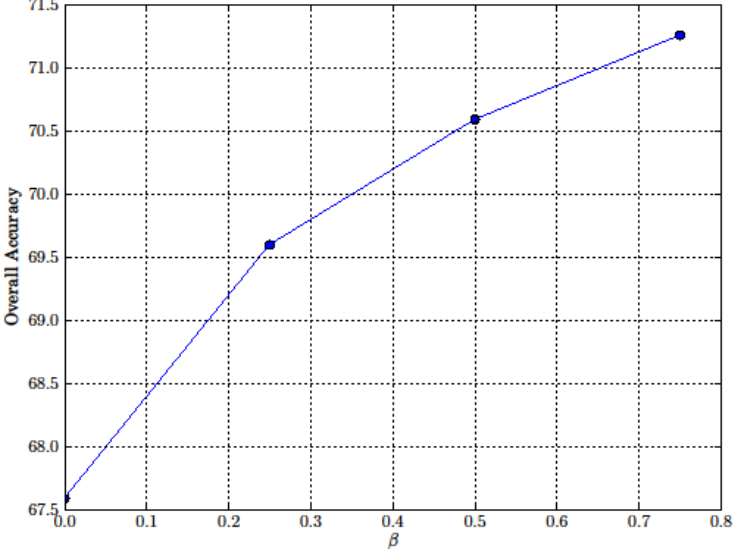
Figure 12. Overall accuracies for different values of β when MI and PAN are perfectly